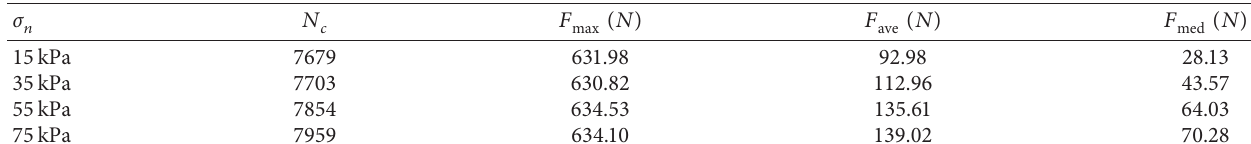
� 15kPa; (b) σ � 35kPa; (c) σ � 55kPa; (d) σ � 75kPa. s of 10%: (a) σ n n n n s of 10%.